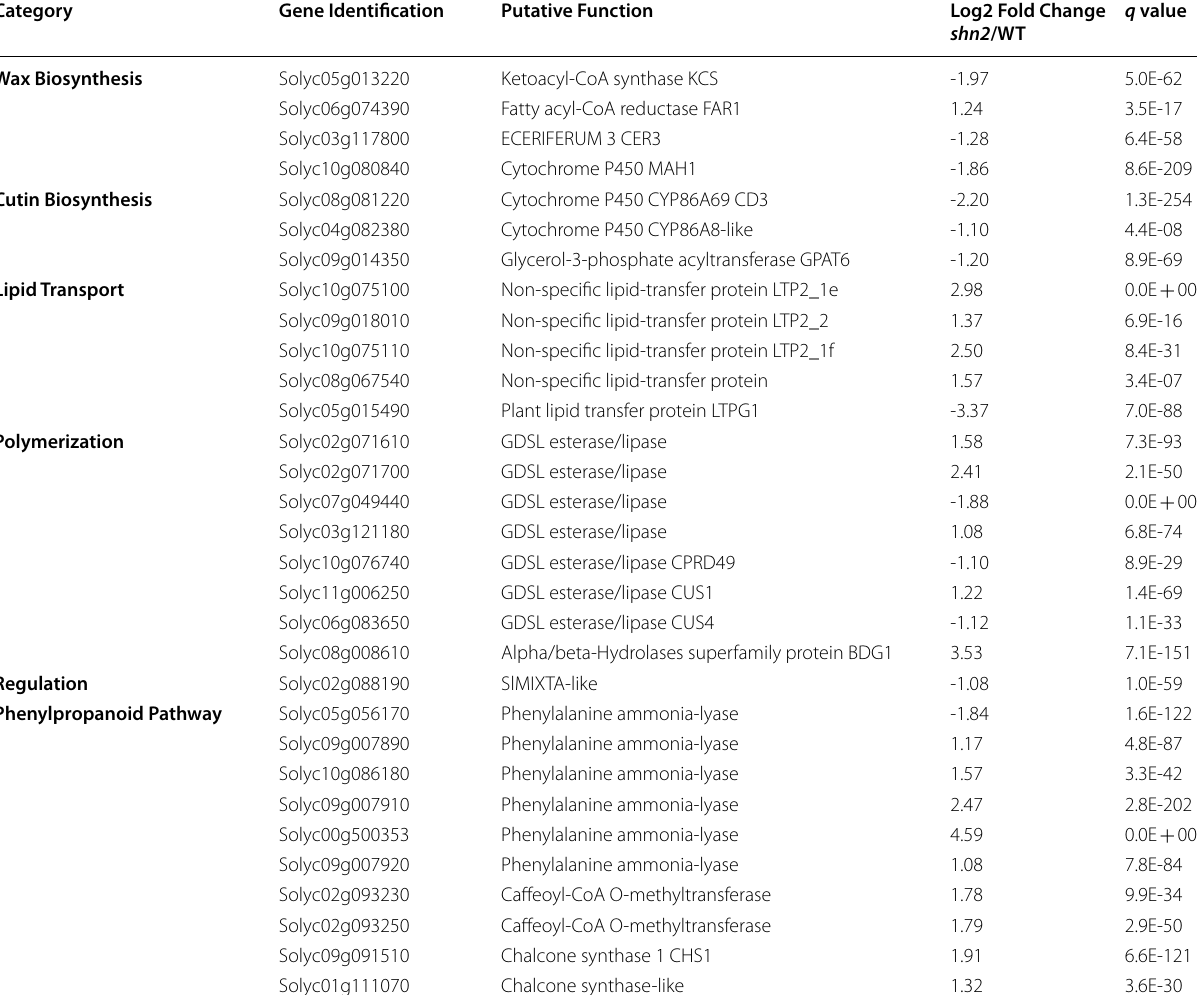
Table 1 Differentially expressed genes (DEGs) associated to cuticle modifications and cell wall polysaccharides Category Gene Identification Log2 Fold Change